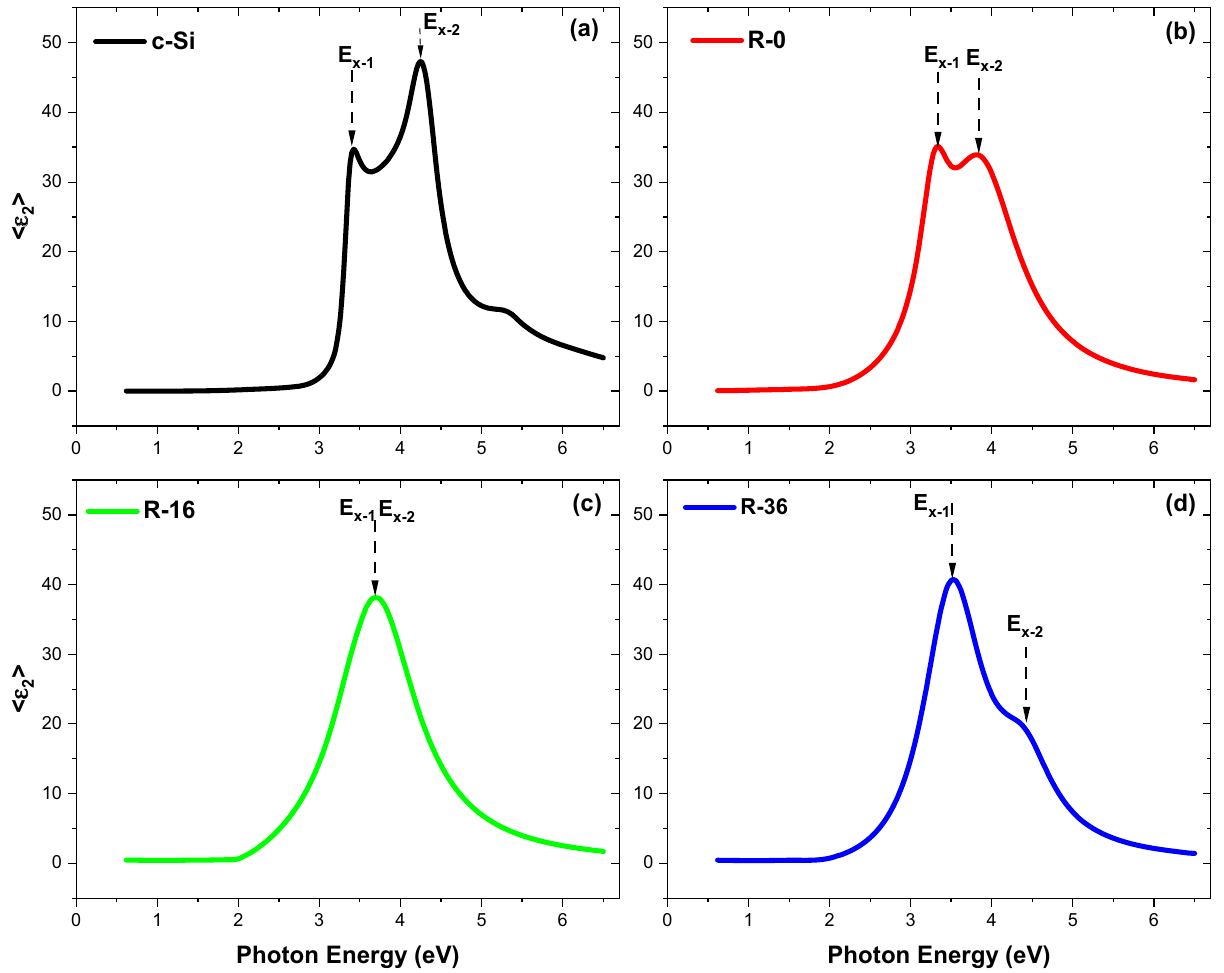
Figure 1. Imaginary part of complex dielectric function (E x−1 : conventional exciton, E x−2 : resonant excitons) <ε 2 > ( a ) c-Si, ( b ) R-0, ( c ) R-16, and ( d )